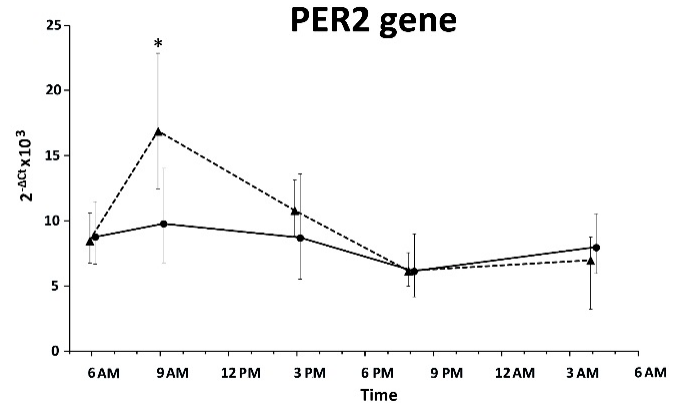
Figure 3. Profiles of Per2 expression in pubic hair follicle cells of shift-working (solid line) and daytime (dashed line) nurses collected for a 24 h period. Data are expressed as the geometric mean ± 95% confidence interval. Statistical significance is indicated by * p < 0.05.